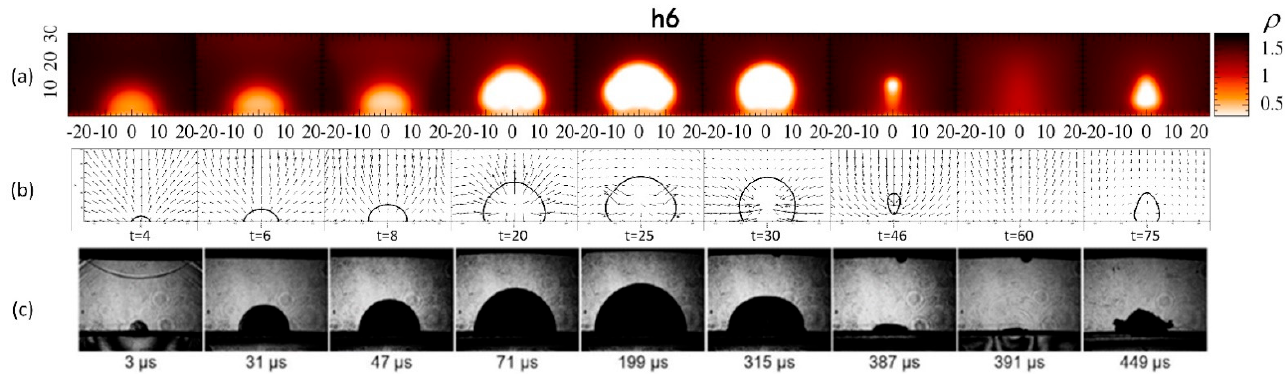
Figure 12. Average bubble radius R(cid:3365) and entropy increase Δ S with time. Damage to a wall from bubble collapse is common and important for cavitation and other vapor-bubble-related applications. However, a consensus has not yet been reached for the mechanism of energy conversion during collapse. Zhang et al. believe that the en- ergy of a bubble is transformed into the wave energy of its fluid, causing an impact on a solid wall [24]. Qin found that when a bubble collapses, there is a large amount of heat transfer and energy exchange between the bubble and the outside [23]. To illustrate the energy conversion during bubble collapse, we can divide the fluid internal energy into two parts as 𝐸 (cid:3022) = 𝐸 ℎ + 𝐸 (cid:3048) , as in Equation (10), with thermal energy 𝐸 ℎ = 𝐶 (cid:3023) 𝑇 and potential energy 𝐸 (cid:3048) = −𝛼(cid:3364)𝜌 , respectively. The fluid kinetic energy 𝐸 (cid:3038) = ∑ (cid:2869) (cid:2870) 𝑚 (cid:3036) 𝑣 (cid:2870)(cid:3047)(cid:3042)(cid:3047)(cid:3028)(cid:3039) (cid:3036)(cid:2880)(cid:2869) is also accounted for to represent the mechanical energy information. The